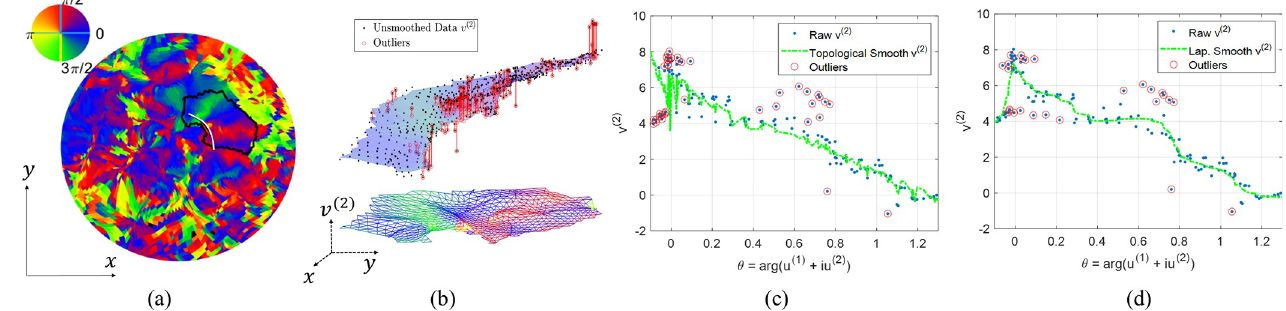
Fig 14. Smoothing is robust to the inaccurate interior boundary: (A) the raw visual polar angle v (2) is rendered on the parametric unit disk (i.e., radius is one), (B) v (2) as a function on the cropped region, (C) visual polar angle v (2) along the white arc by topological smoothing, (D) similar result as (C) but the curve is from Laplacian smoothing.